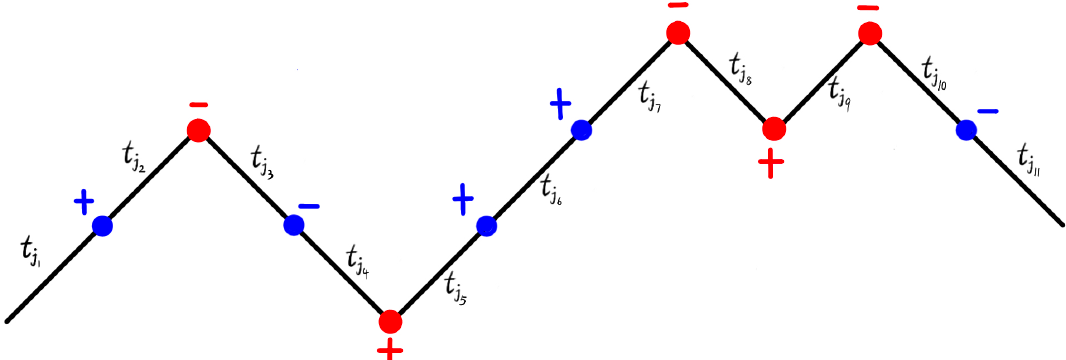
Figure 2 . Schematic diagram of κ . Line segments represent different times, and they are connected by point (plus or minus). The blue point means the sign has not changed, while the red point means the sign has changed. There are five red points in the picture, therefore we have κ = 5